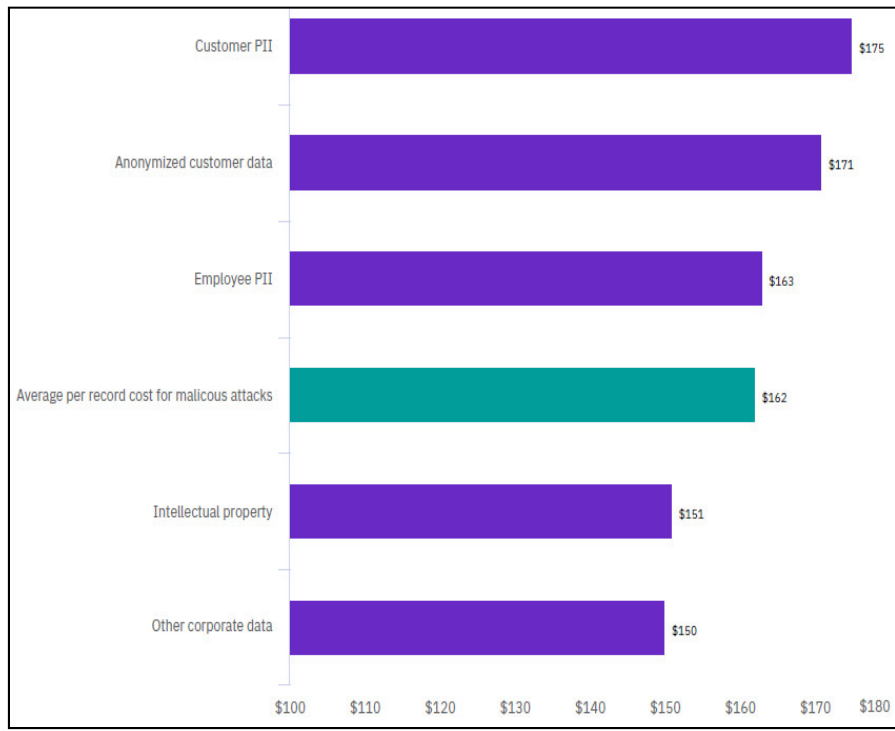
Figure 2. Average cost per record by type of data compromised in a malicious attack [6].